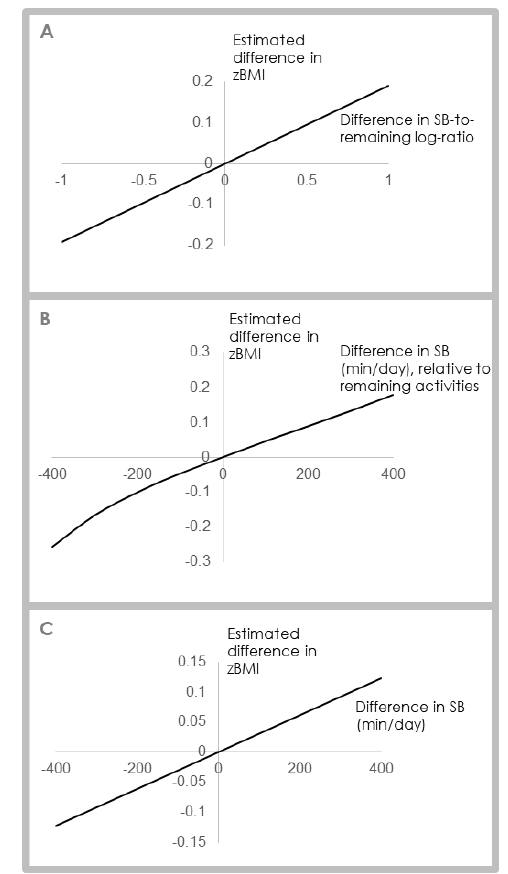
Figure 6. Relationship between daily activity behaviors (specifically SB) and zBMI. Panel A: Difference in zBMI associated with difference in SB-to-remaining activities expressed as a pivot coordinate, as estimated by compositional linear regression. Panel B: Difference in zBMI associated with difference in SB-to-remaining activities expressed in min/d, as estimated by compositional linear regression. Panel C: Difference in zBMI associated with difference in SB (min/d), as estimated by linear regression. Data are from the Longitudinal Study of Australian Children, Wave 6, birth cohort. All analyses adjusted for sex, age and socioeconomic position. zBMI = body mass index z-score; SB = sedentary behavior.